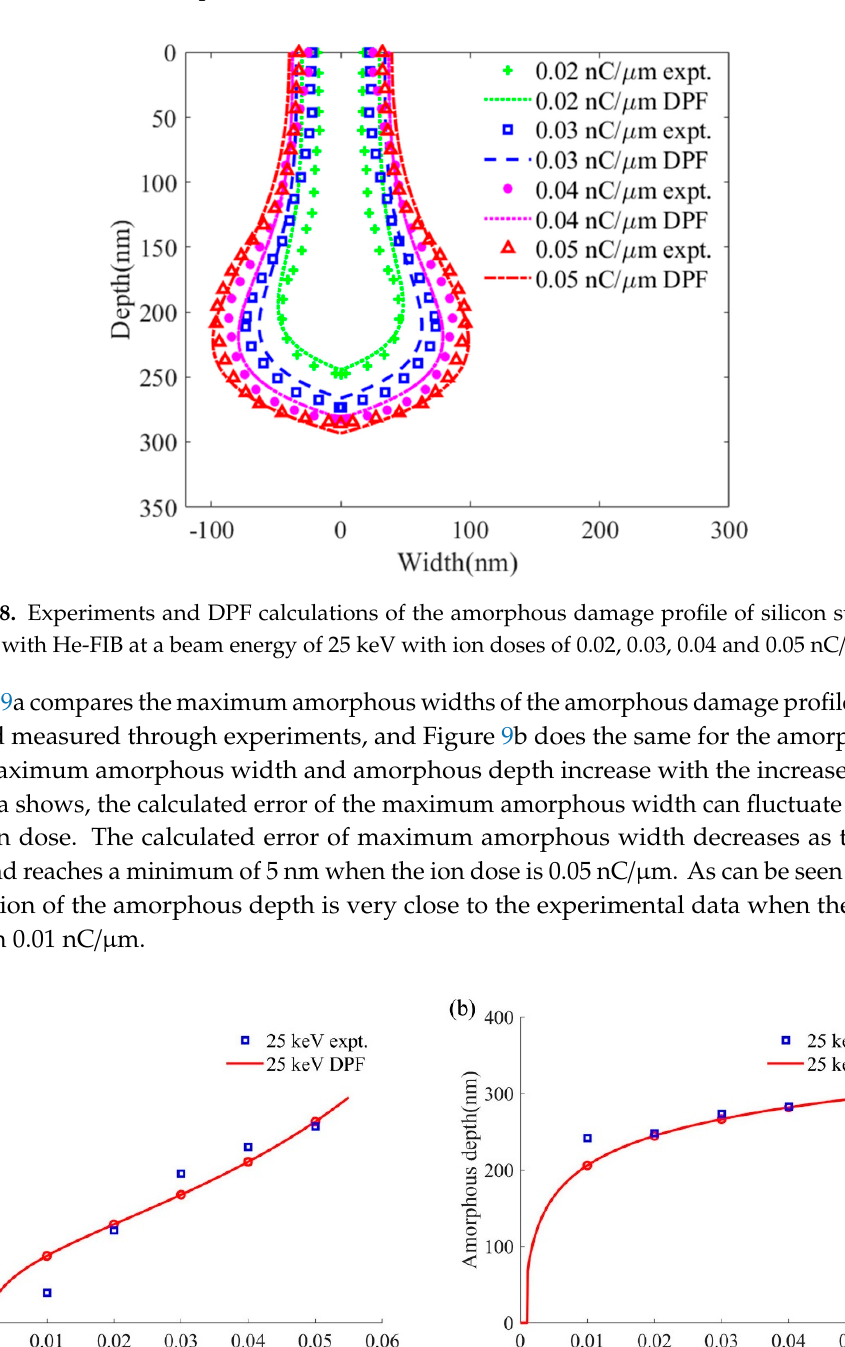
Figure 9. Comparison of experiments and DPF calculations of the amorphous damage profile characteristic dimensions of silicon substrate treated with He-FIB at a beam energy of 25 keV: ( a ) Maximum amorphous width; ( b ) Amorphous depth.